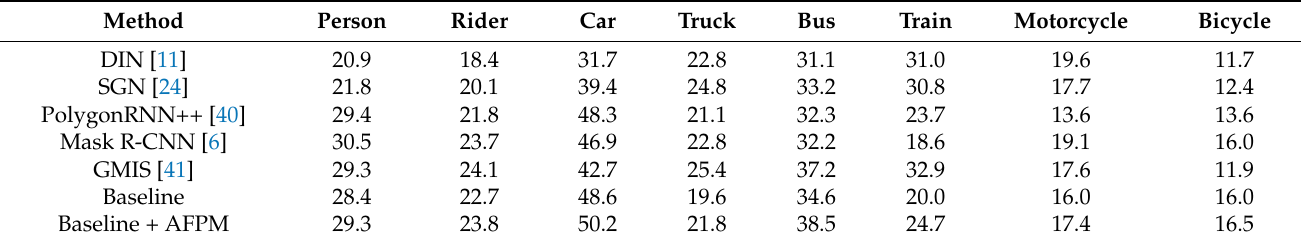
Table 7. Comparison of average precision (AP) (%) for each instance class on the Cityscapes test set.